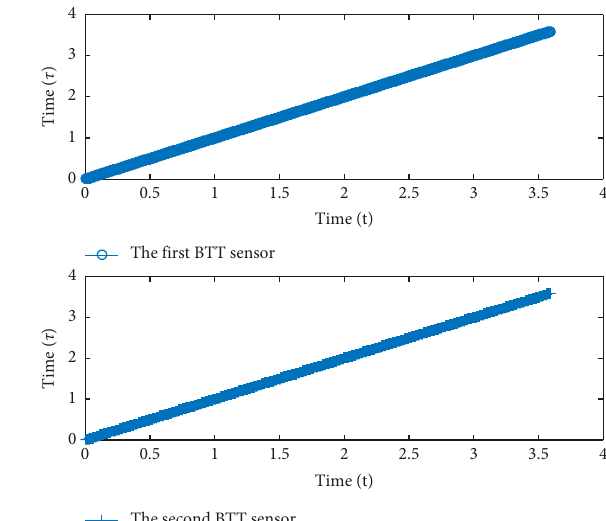
Figure 11: The two inverse functions in equation (26).